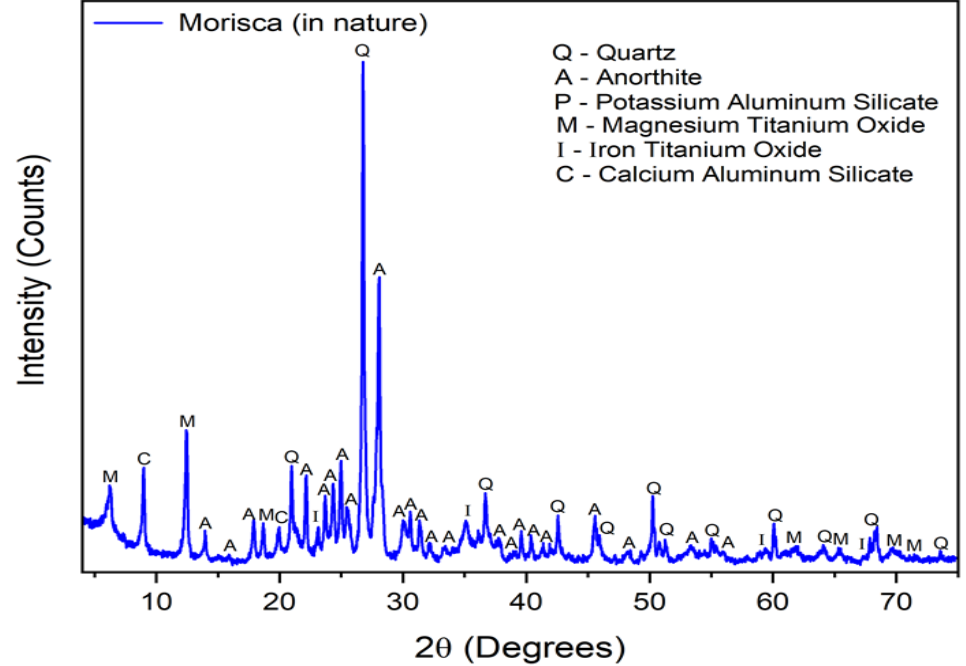
Figure 3. XRD pattern of raw morisca (in nature). Step size of 0.02° min − 1 .